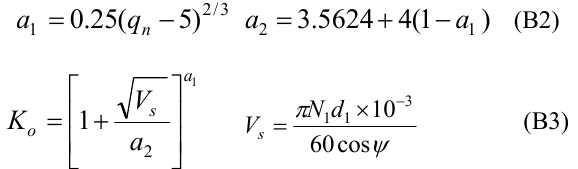
Table A1: Material Friction Factor, [31] Worm Material